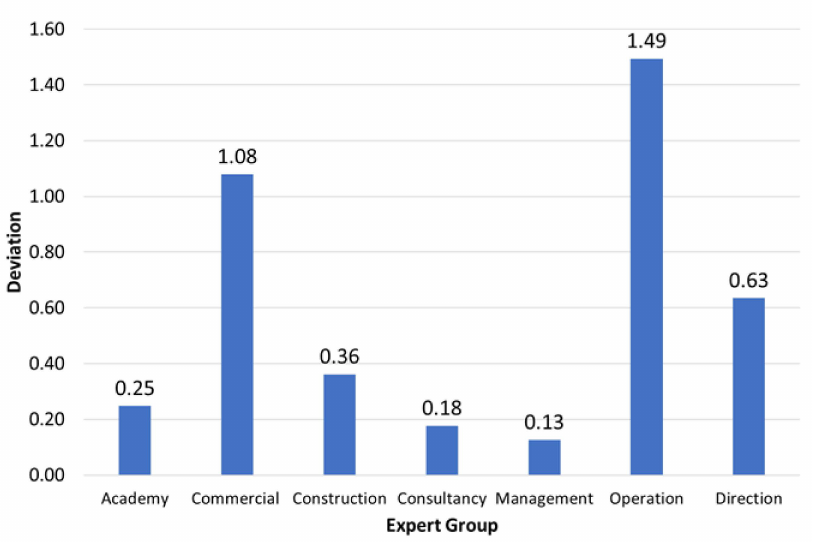
Figure 6. Deviation values of every expert